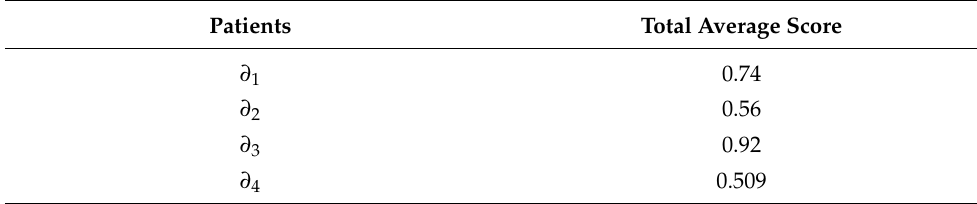
Table 11. Personal information from patient significance levels related to clinical manifestations.